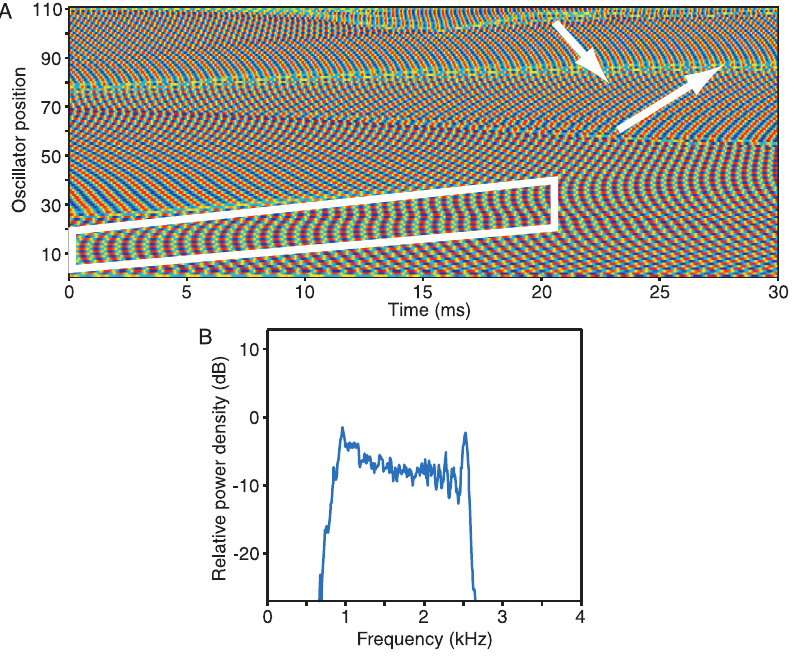
Figure 2. The effect of viscous coupling. A. In this spatiotemporal plot of the system’s behavior in the presence of viscous coupling, the abscissa represents time. The ordinate displays the behavior of the 110 coupled oscillators, with those of progressively higher natural frequencies situated toward the top. Colors encode the instantaneous values of the hair-bundle displacement x , with red representing positive values, blue negative values, and green values near zero. The oscillators display waves of synchronization moving along the chain in both directions (arrows) and regions of antiphase synchronization (polygon) B. The power spectrum for the same system shows a concentration of power in the frequency range 0.7–2.6 kHz but no well-defined peaks. In this and subsequent figures, the spectral power density is defined relative to that produced by a single, free-running oscillator at its natural frequency. The simulation covered the equivalent of 1.6 s, and the spectrum presented is the average of the power spectra from 47 overlapping segments lasting 128 ms each. The parameter values for the simulations are provided in Table 1.